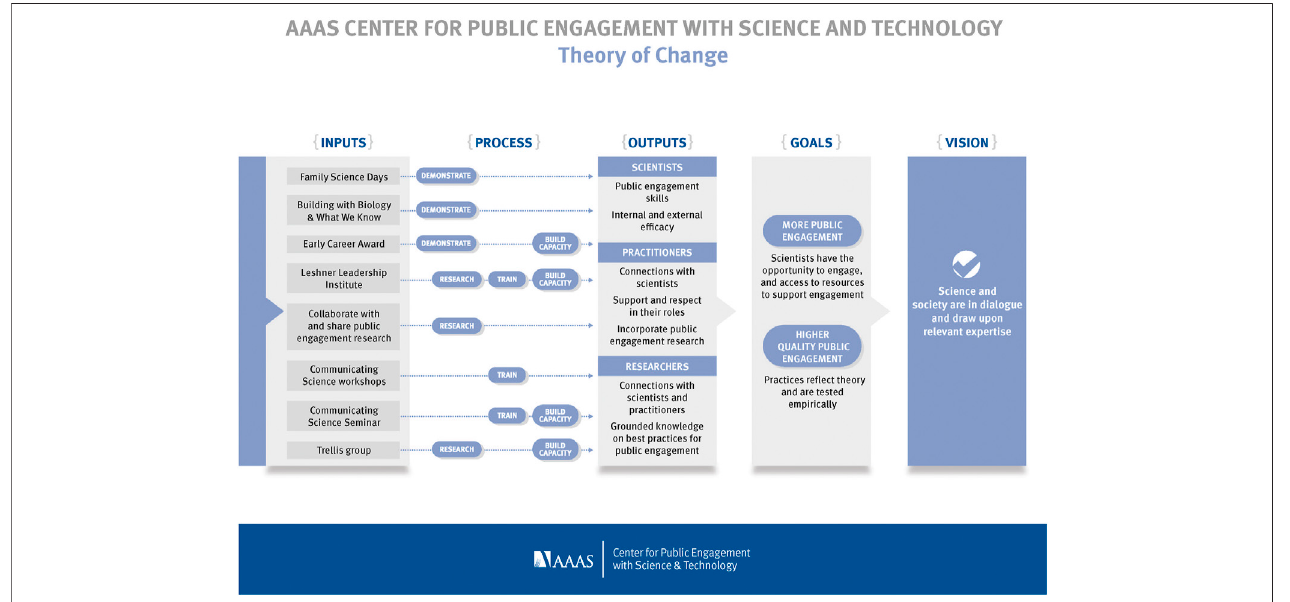
FIGURE 1 | Theory of change for the AAAS center for public engagement with science and technology